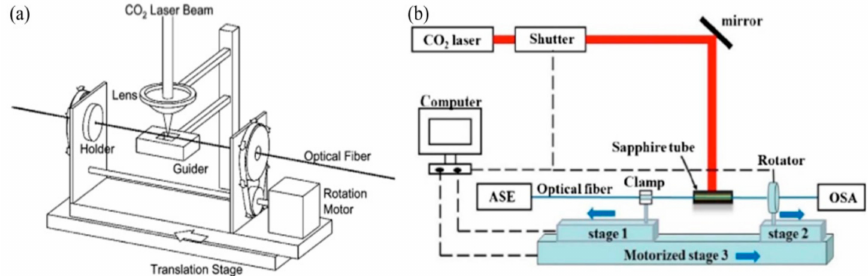
Figure 2. ( a , b ) Experimental setups for fabricating the helical LPFG (HLPFG) by use of CO 2 laser [10,11].